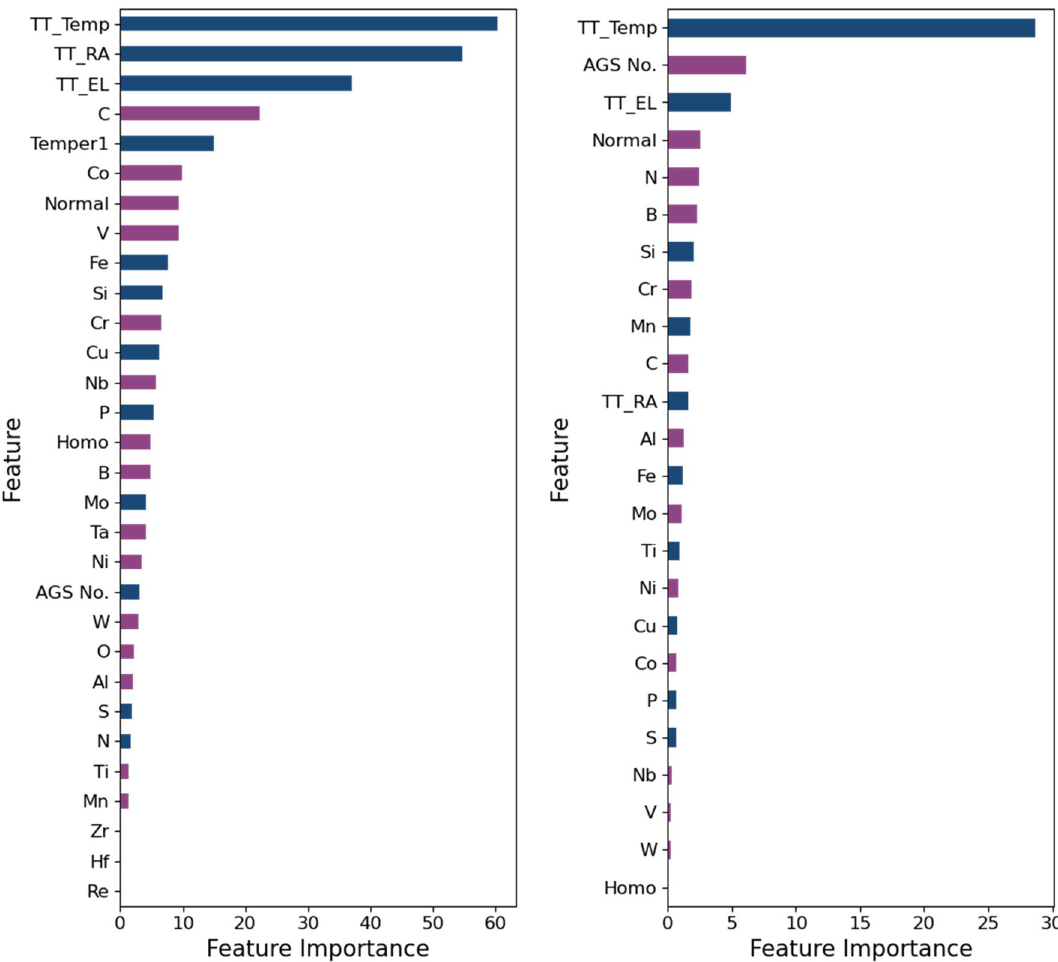
Figure 5. Importance of different features for the 9–12% Cr FMA (left) and austenitic stainless steel (right). The x-axis is plotted in terms of arbitrary unit to show the relative importance of different features, but the magnitude has no physical interpretation. Purple color indicates positive correlation while dark blue color indicates negative